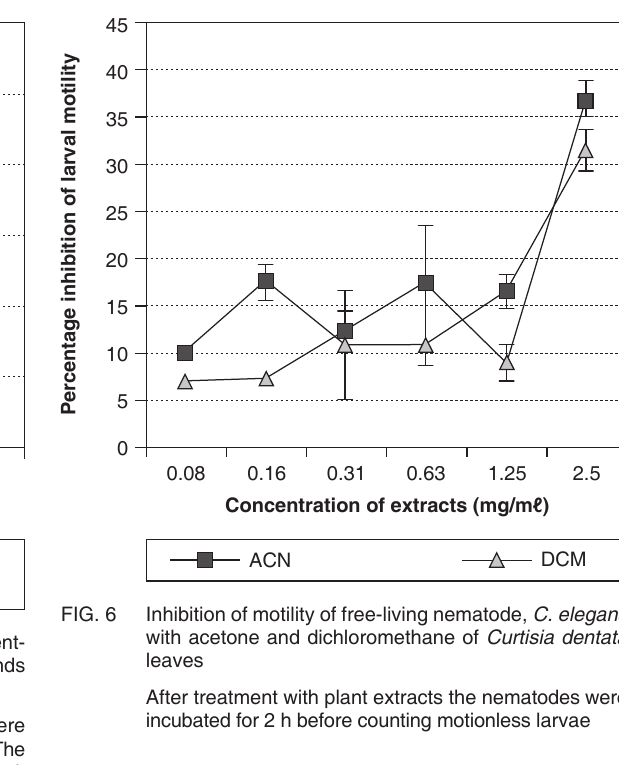
incubated for 2 h before counting motionless larvae. The